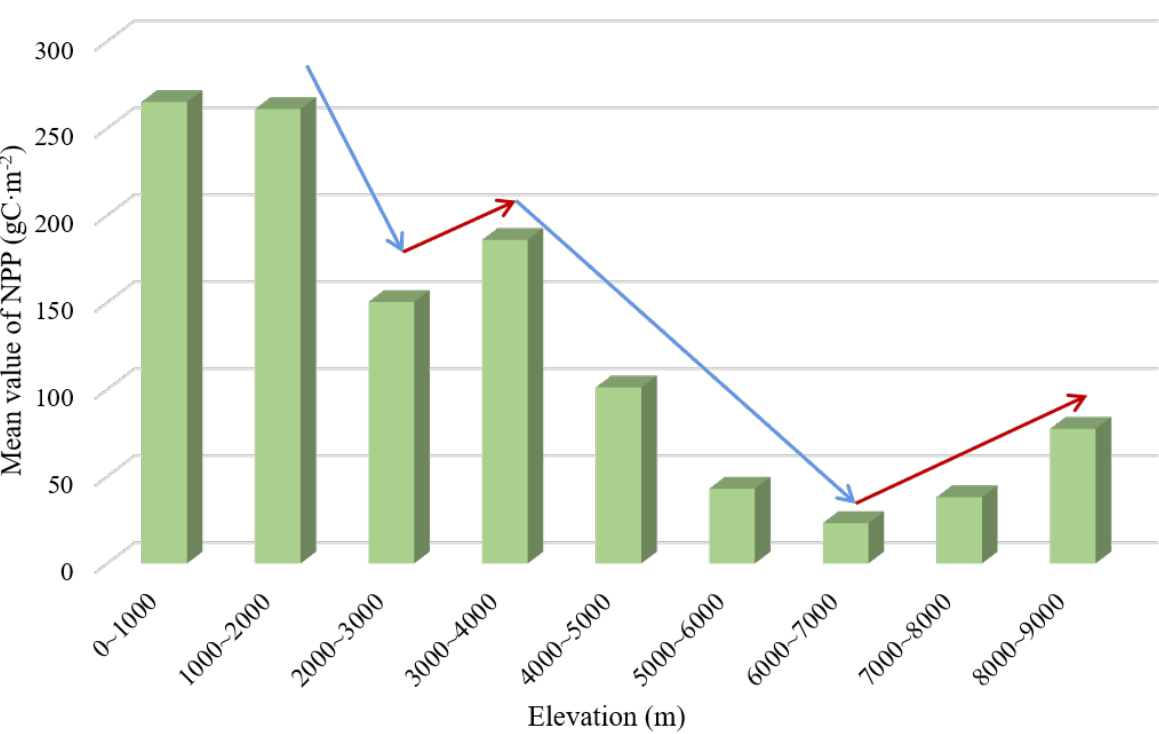
Figure 10. The response of NPP change to elevation: average value of NPP in different elevation sections. We calculated the average temperature and precipitation at different altitudes from 2001 to 2017 (Figure 11). The value of precipitation was mainly distributed between 275.82 mm and 712.89 mm, and its variation trend was similar to that of NPP in different elevation sections. The temperature was mainly distributed between − 23.15 ◦ C and 22.15 ◦ C, and the higher the altitude, the lower the temperature. In the elevation range of 1000 ~ 2000 m and 8000 ~ 9000 m, the precipitation was roughly the same, but the difference of NPP value (183.77 gC · m − 2 ) was caused by the difference of temperature. Therefore, elevation affected the NPP by affecting the value of temperature and precipitation.